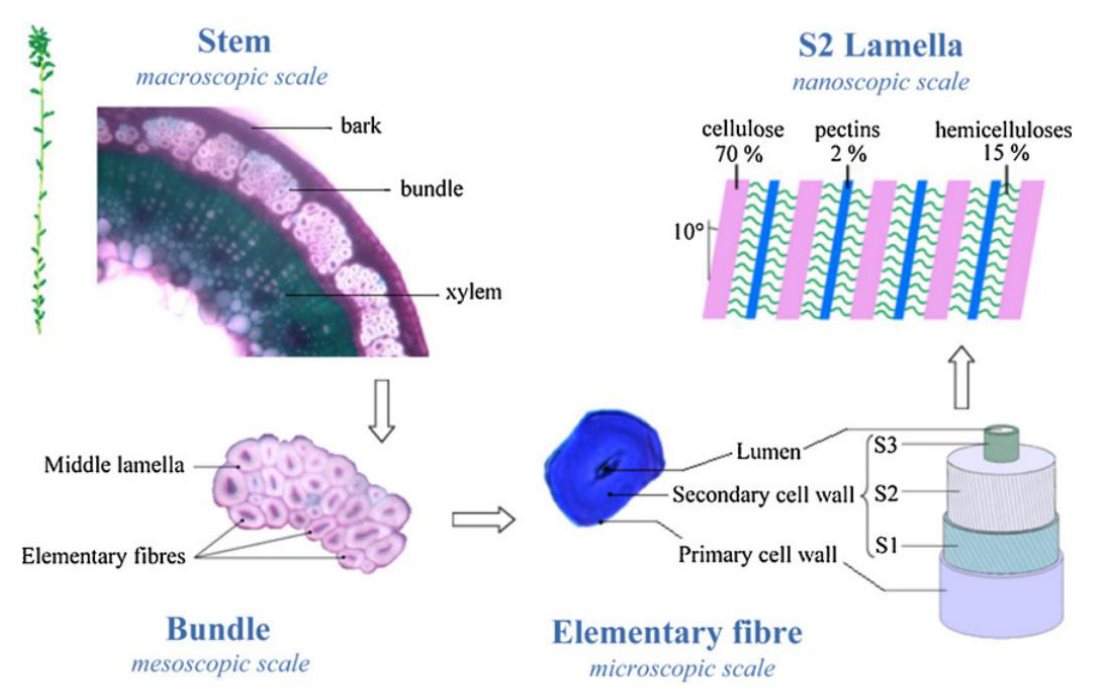
Figure 2. Composition and cross section of flax stems. Adapted with permission from